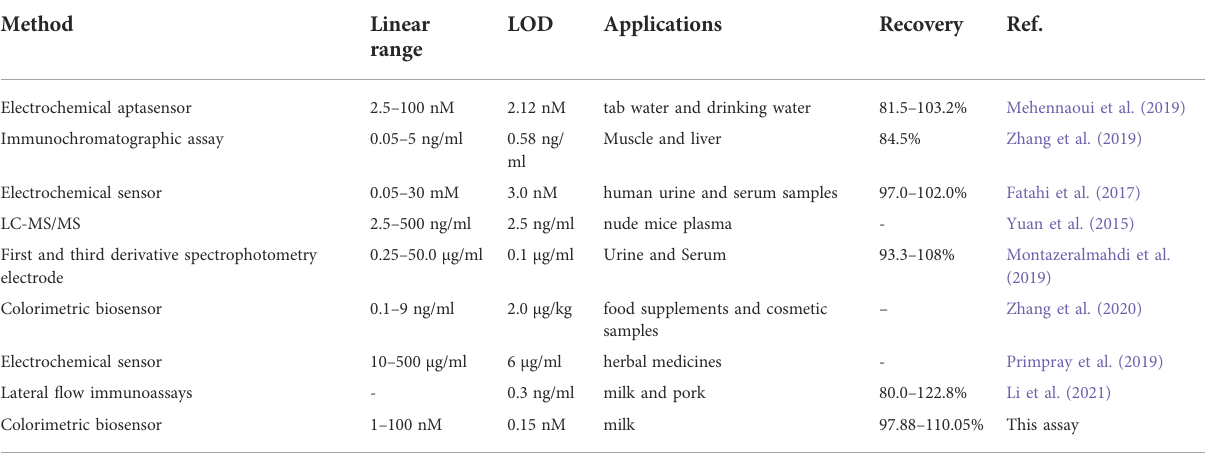
TABLE 3 Comparable methods for determination of